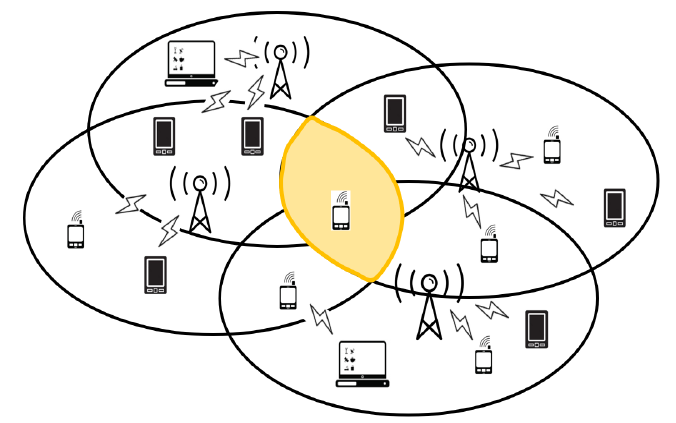
Figure 1. Scenario of hyper-dense APs: multiple inter-BSS NAVs may deteriorate medium utility chance of STA in